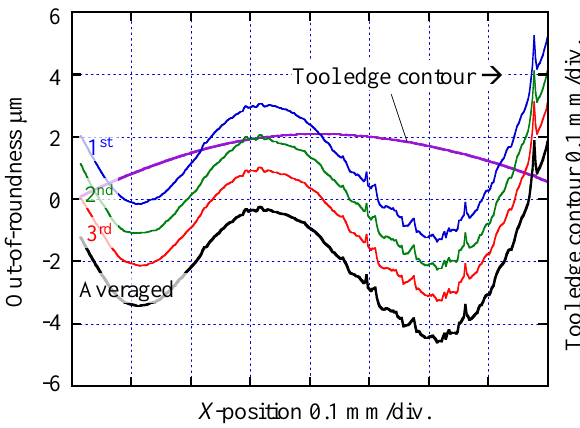
Figure 13. Edge contour and out-of-roundness measured by the raster-scan